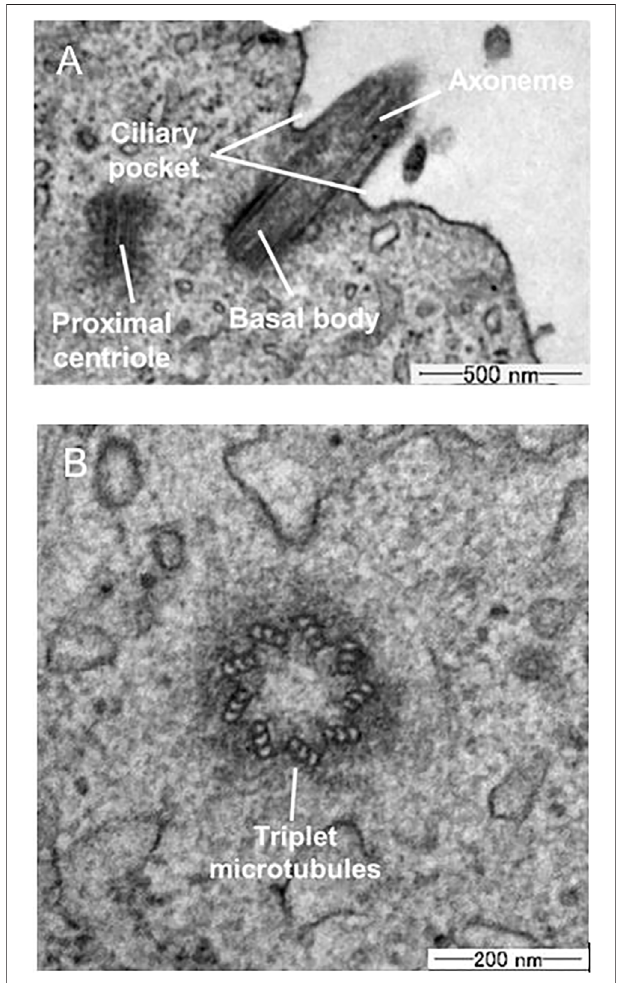
FIGURE 3 | TEM images (A) Longitudinal section (B) Cross-section of primary